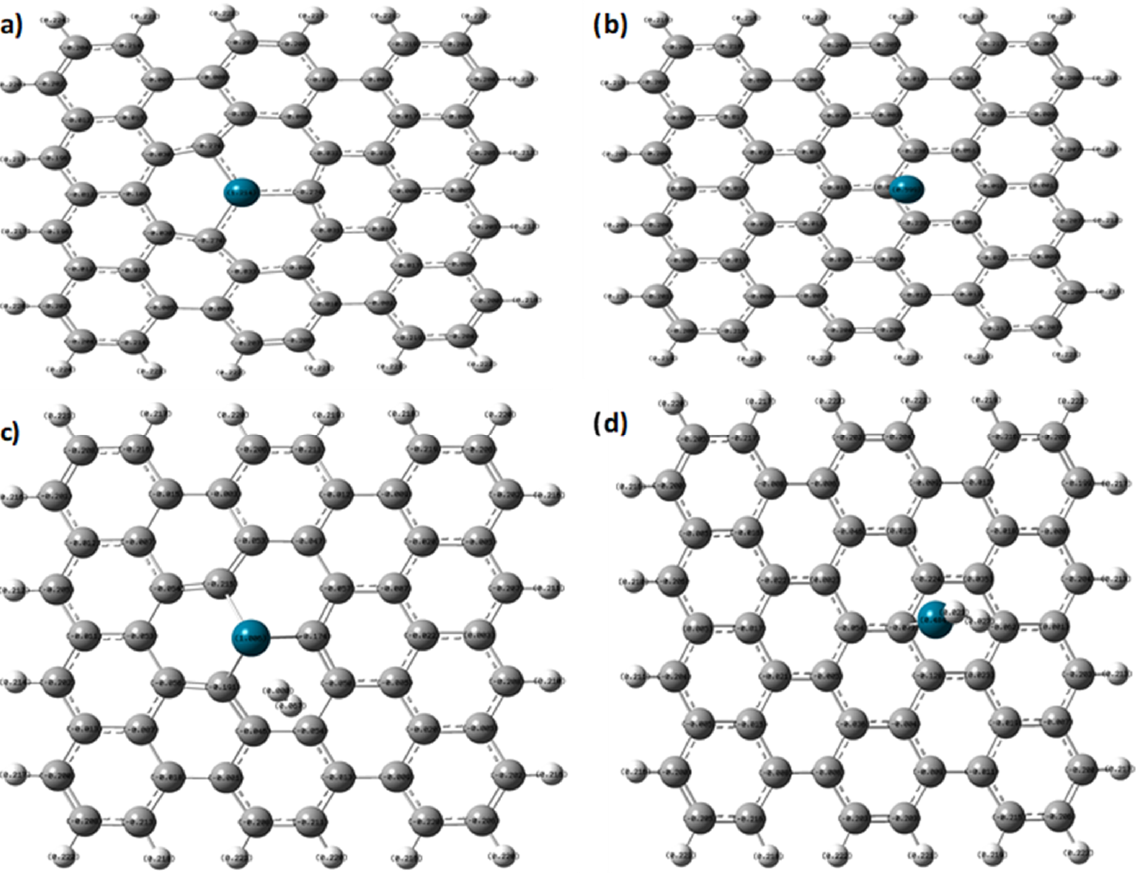
Figure 3. NBO atomic charge distributions for the optimised structures of ( a ) Pd-doped graphene, ( b ) Pd-decorated graphene, ( c ) Pd-doped graphene-H 2 , and ( d ) Pd-decorated graphene-H 2.